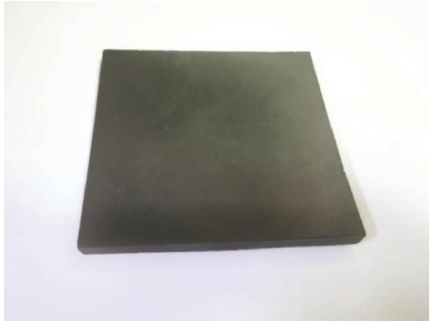
Figure 2: Rubber viscoelastic